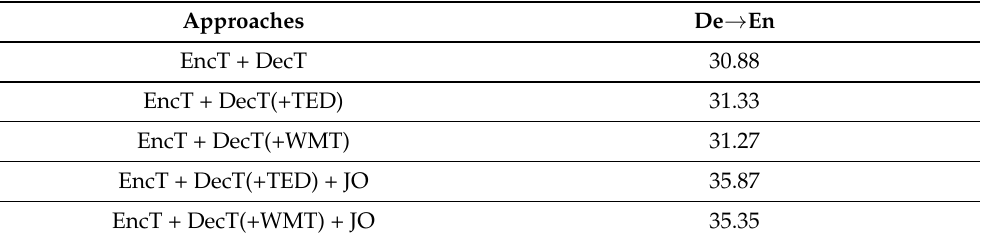
Table 7. Effectiveness of the decoder training using an additional large-scale monolingual corpus of the target language. DecT(+TED) and DecT(+WMT) mean that we used the additional TED and WMT in decoder training,